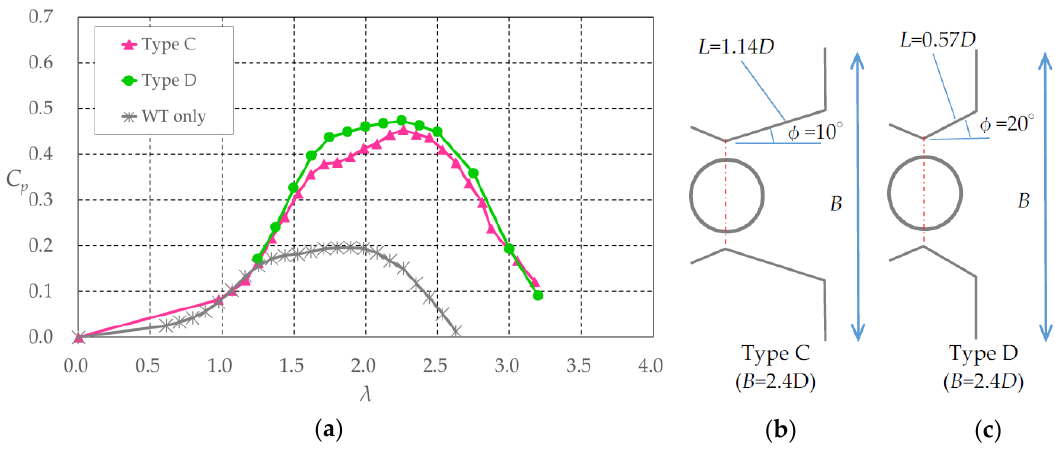
Figure 6. ( a ) Power coefficient C p of wind turbines with and without a wind lens vs. tip speed ratio λ (flange width: h = 0.5 D m); ( b ) plan view of the wind lens of type C; and ( c ) plan view of the wind lens of type D. Refer to Figure 2 for h , and D .